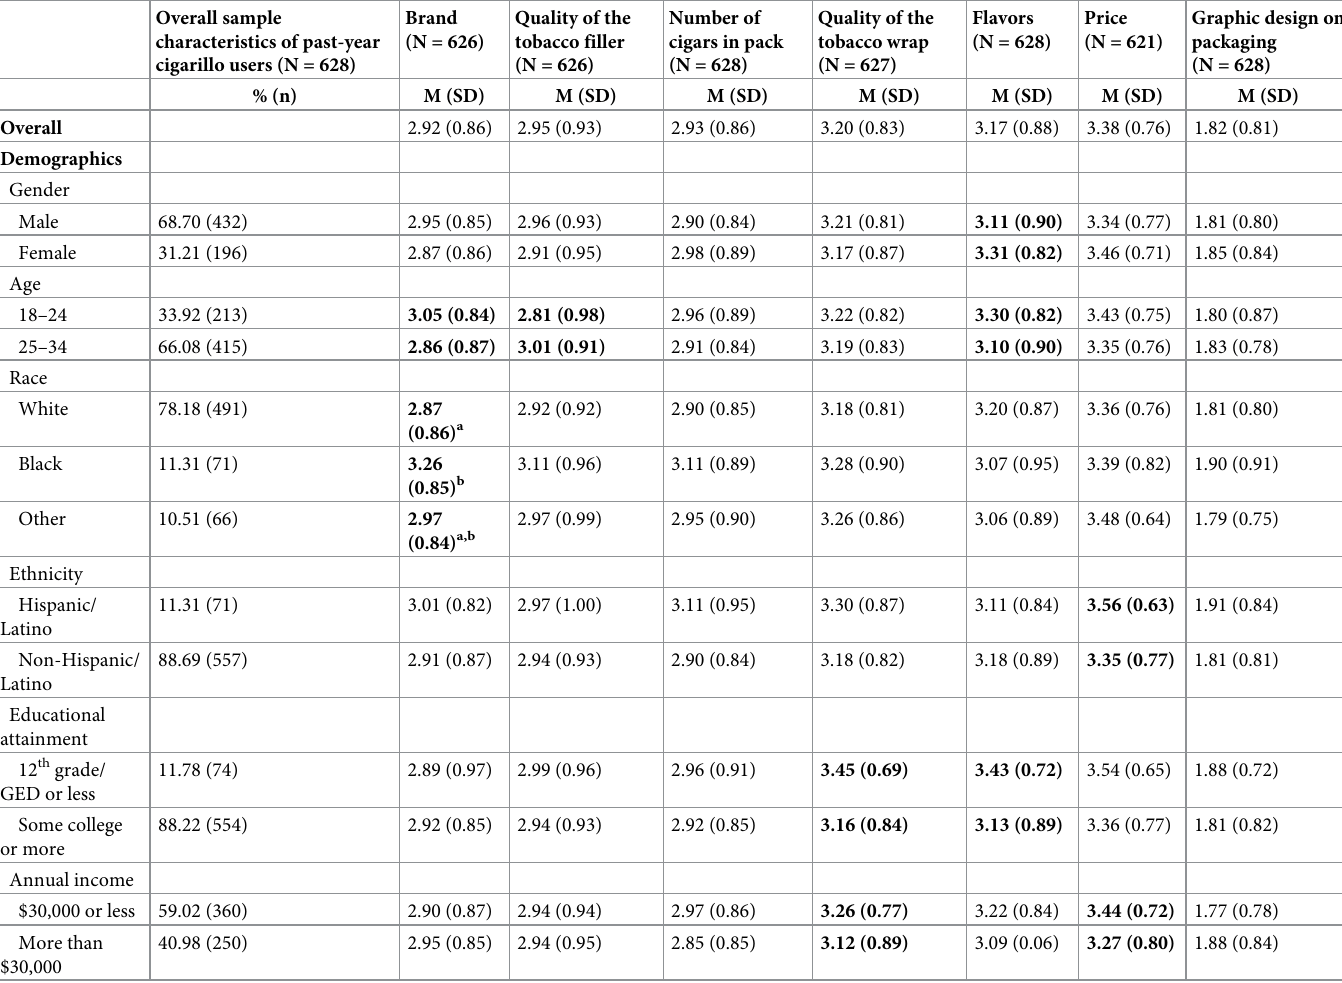
Table 1. Mean importance of cigarillo product characteristics by